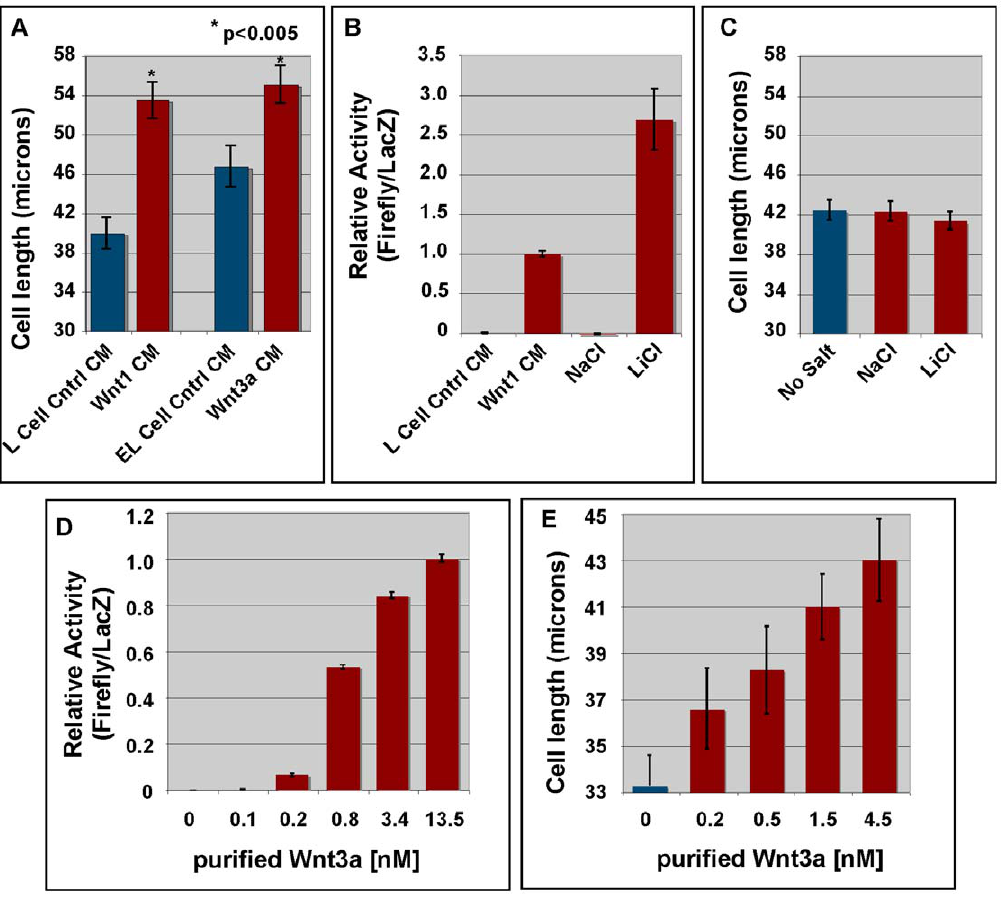
Figure 6. Wnt1/3a promote L cell elongation via a ß-catenin independent pathway. Panel A: Mock-transfected L cells were treated with control-conditioned media (Control-CM) or Wnt1/3a-conditioned media for 24 hrs. Note that Wnt1-CM was produced by standard L cells while Wnt3a was produced by E-cadherin transfected L cells (EL cells). Cells were then fixed, immunostained for PDI, and imaged with a confocal microscope. The length of the long axis of cells was measured using Adobe Photoshop (version 9.0.2). Error bars represent standard error. This experiment was repeated twice. At least 100 cells in 5 fields were measured. A Student’s t-test shows that the difference in cell length between cells treated with control-CM and Wnt1- or Wnt3a-CM is statistically significant (p , 0.005). Panel B: LS/L cells were treated with control-CM from mock-transfected L cells, Wnt1 conditioned medium, 33 mM NaCl, or 33 mM LiCl for 20–30 hrs and then assayed for activation of the SuperTopFlash reporter. Panel C: L cells were treated with 33 mM NaCl or LiCl for 24 hrs and then analyzed for cell elongation as in Panel A. Error bars represent the standard error from over 150 cells in two independent experiments. Neither NaCl nor LiCl has any significant effect on the length of the cells. Panel D: Purified mWnt3a was added to LS/L cells 24 hrs prior to conducting a dual luciferase assay to measure the activation of the SuperTopFlash construct. Error bars represent the standard error from 2 independent replicates with a total of 8 data points. Panel E: Mock-transfected L cells were incubated with purified mWnt3a for 24 hrs. Cells were then fixed, immunostained with anti-PDI, and imaged via confocal microscopy. The length of the long axis of individual cells was measured in Adobe Photoshop. Error bars represent the standard error from 2 independent replicates with a minimum of 107 cells measured for each data